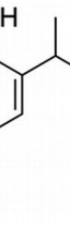
Figure 1. The chemical structure of carnosic acid.